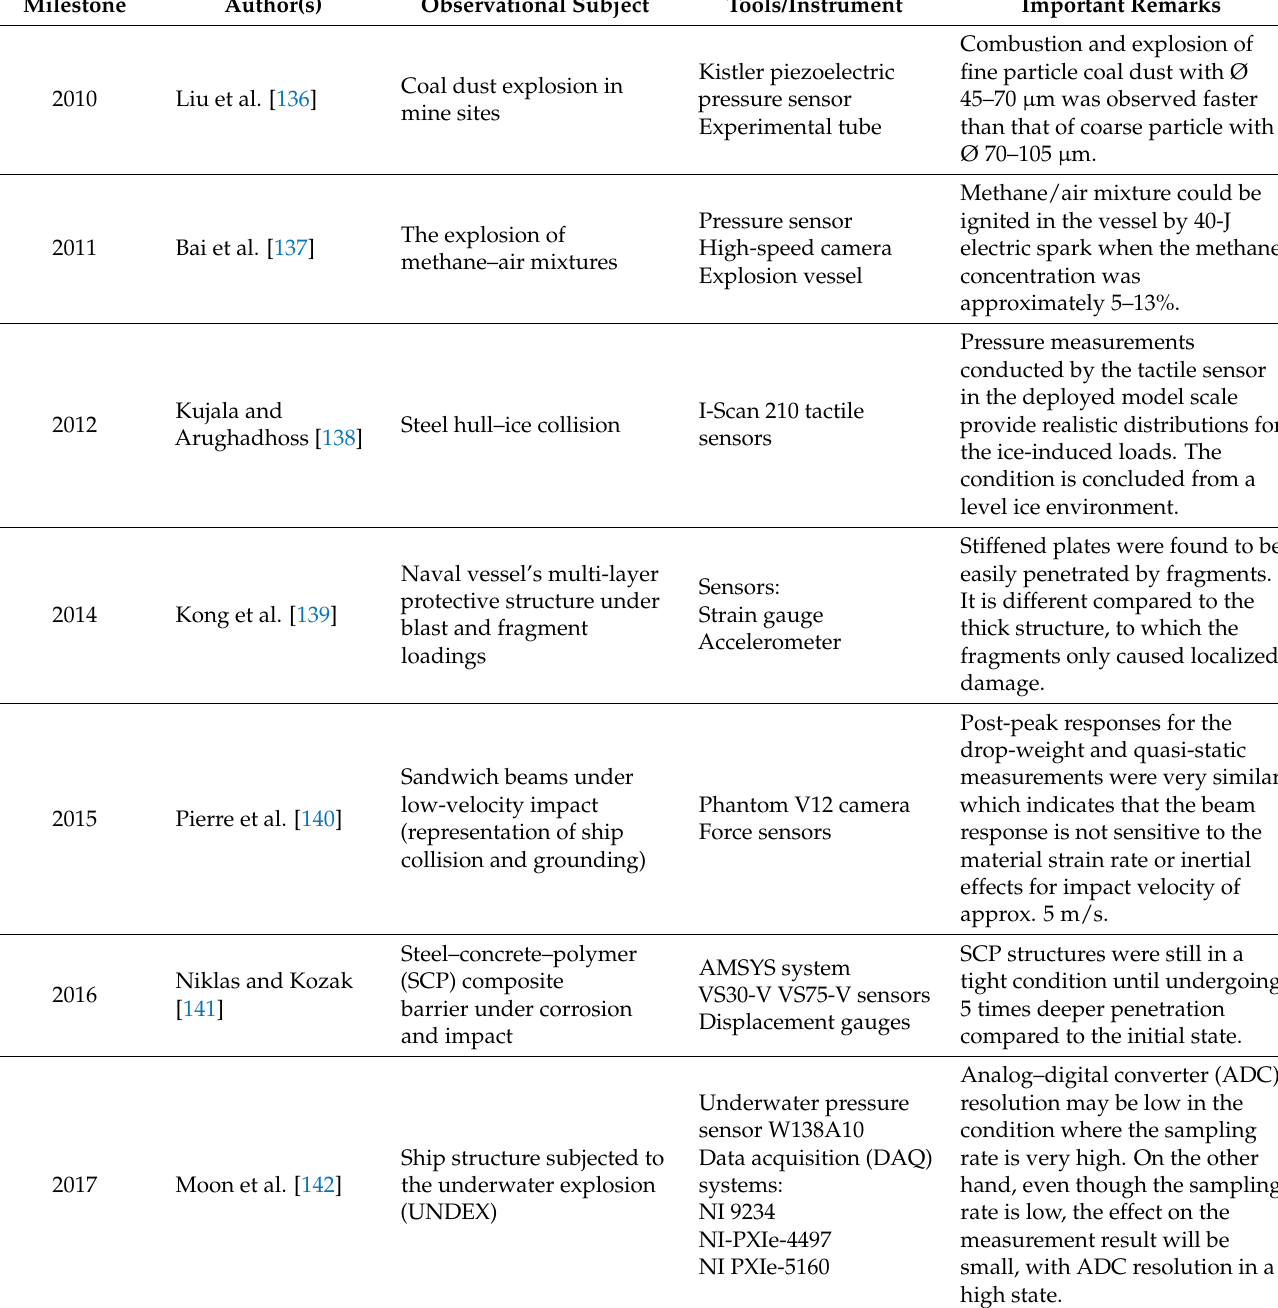
Table 11. Summarized findings of the sensor-based research on measuring impact and